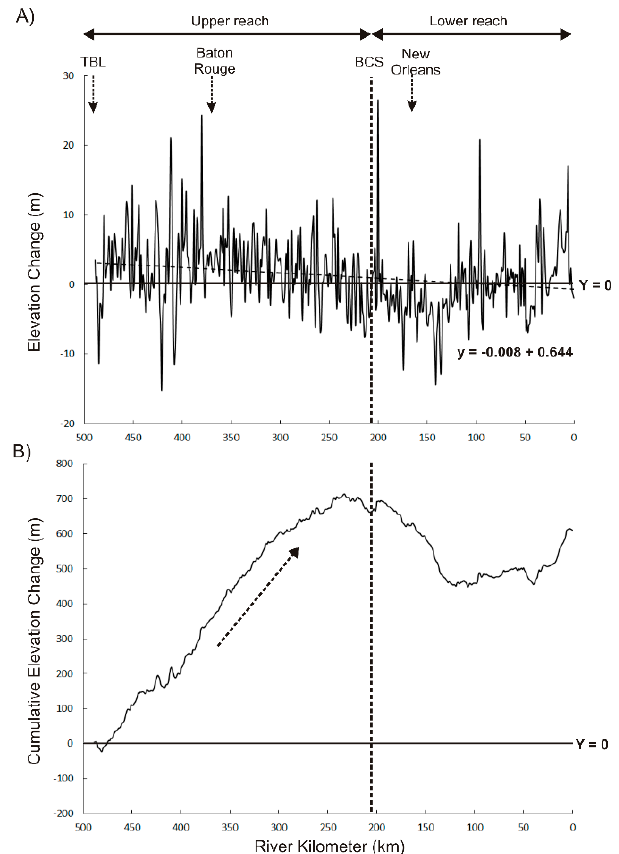
Figure 7. Changes to the thalweg profiles between 1952 and 2013 in the LMR: ( A ) linear regression (dashed line) of elevation change; ( B ) cumulative elevation change, where the dashed line with an arrow represents a constant aggradation trend. Different locations are also labeled to represent the relative position. Note that location of the BCS (labeled as a dashed line) serves as the break point of the upper and lower reaches in our study.